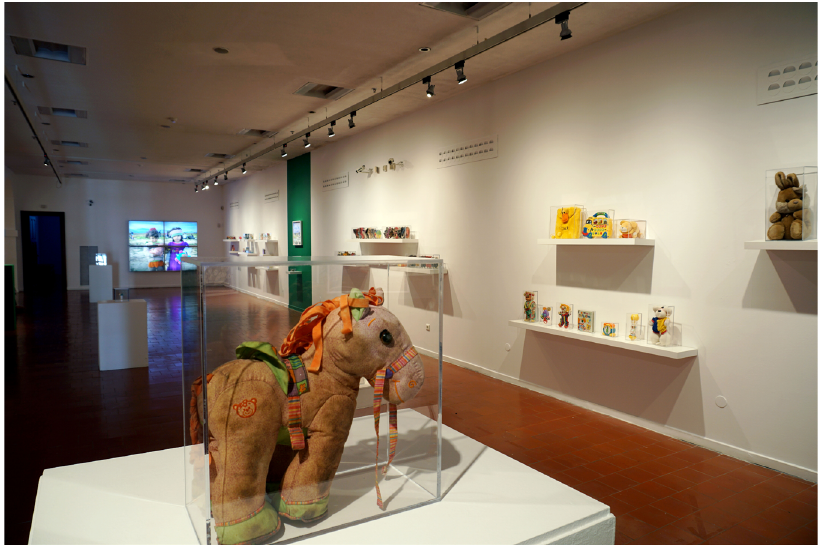
Figure 20. Children toys left at the makeshift refugee camp of Idomeni (photos George Katsagelos).